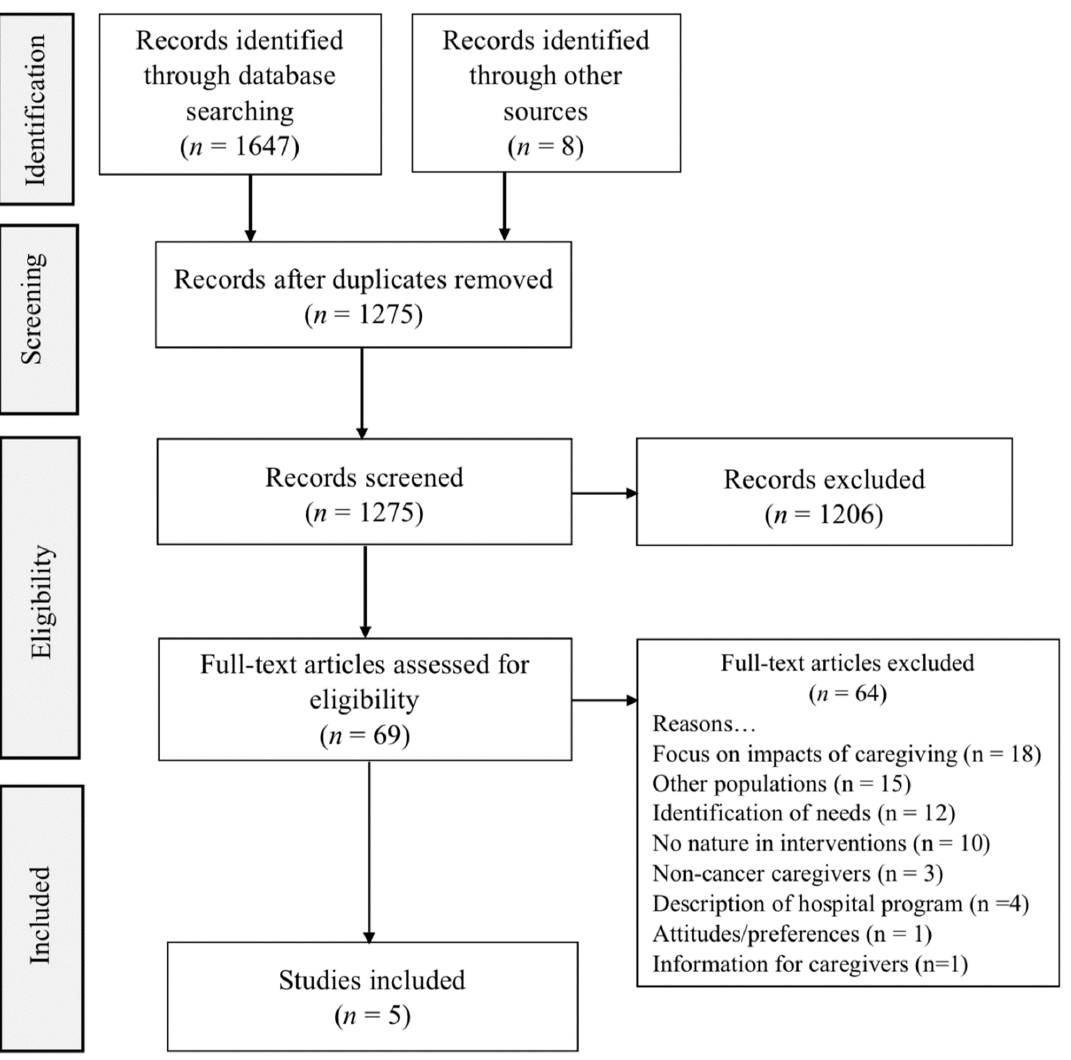
Figure 1. PRISMA-ScR diagram of search strategy.